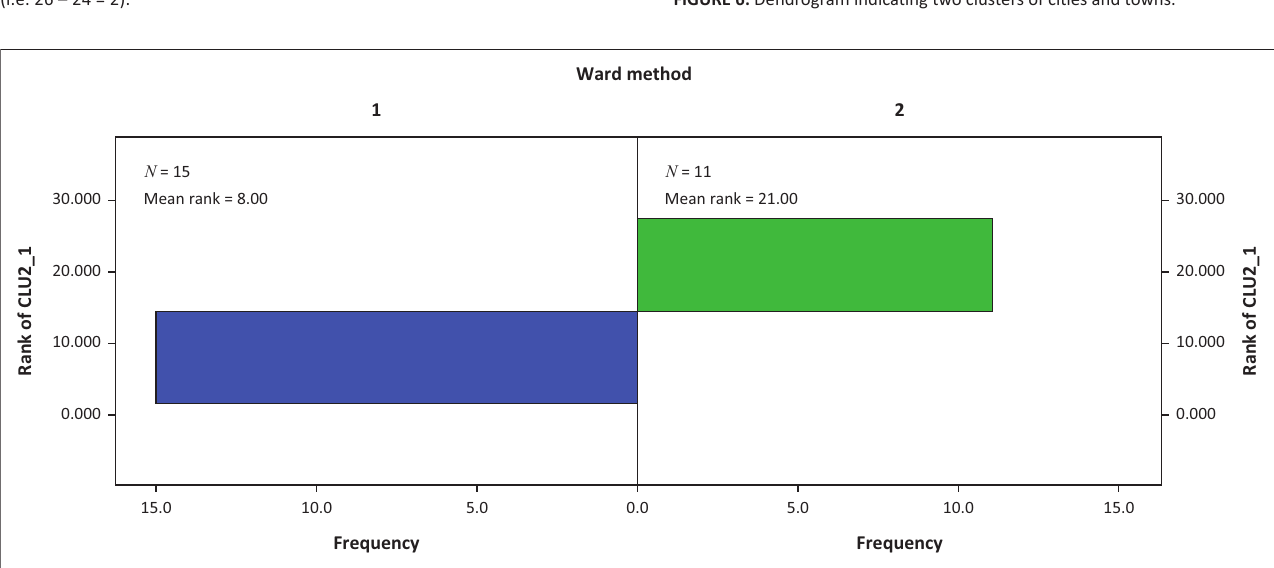
FIGURE 4: Agglomeration curve. As the ‘step of elbow’ shown by a big black dot appears to be at case number 24, a two-cluster solution should be used (i.e. 26 – 24 = 2).